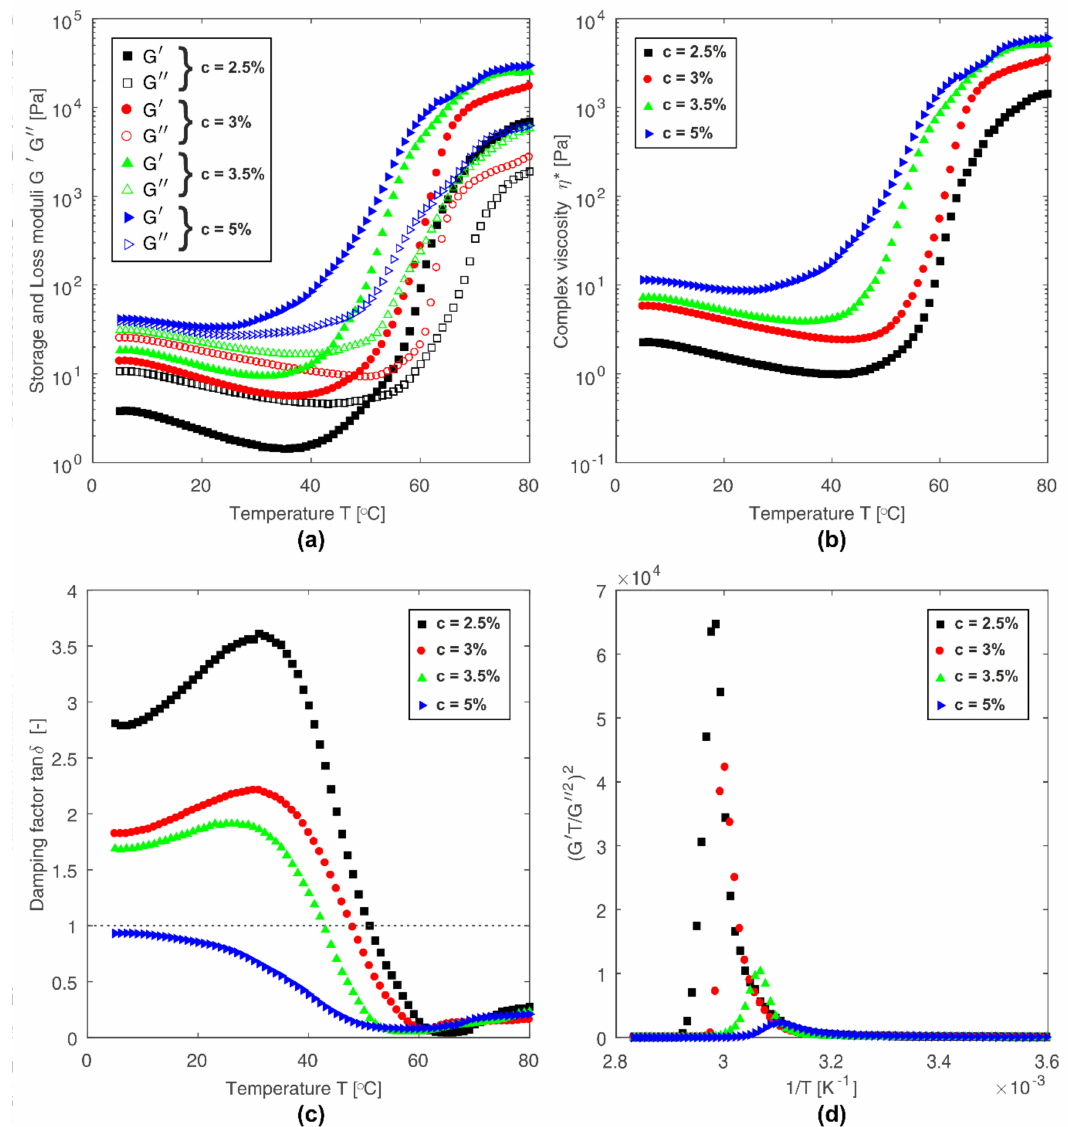
Figure 4. Rheological data of phase transition for all tested samples. ( a ) Changes in storage G’ and loss G” moduli as a function of temperature. ( b ) Complex viscosity η * as a function of temperature. ( c ) Damping factor tan δ as a function of temperature. ( d ) Gelation temperature determined by the Fredrickson-Larson